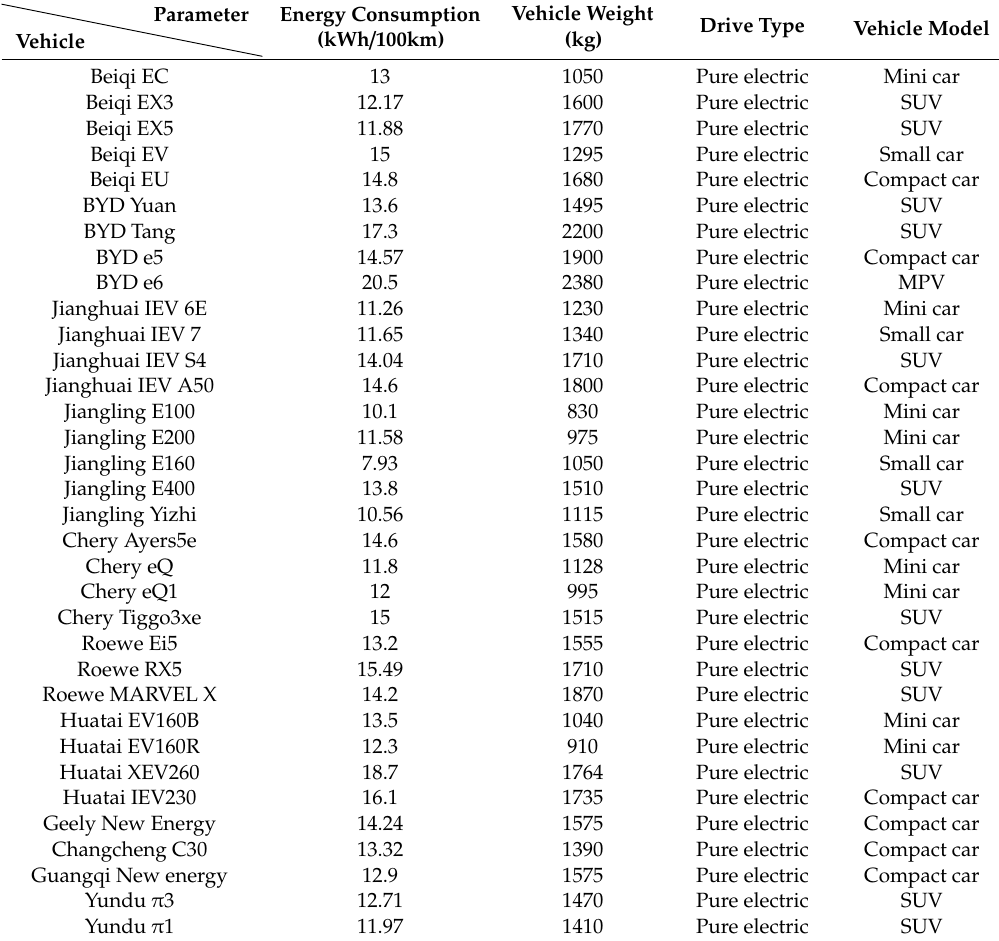
Table A1. The parameters of the 34 electric vehicles.